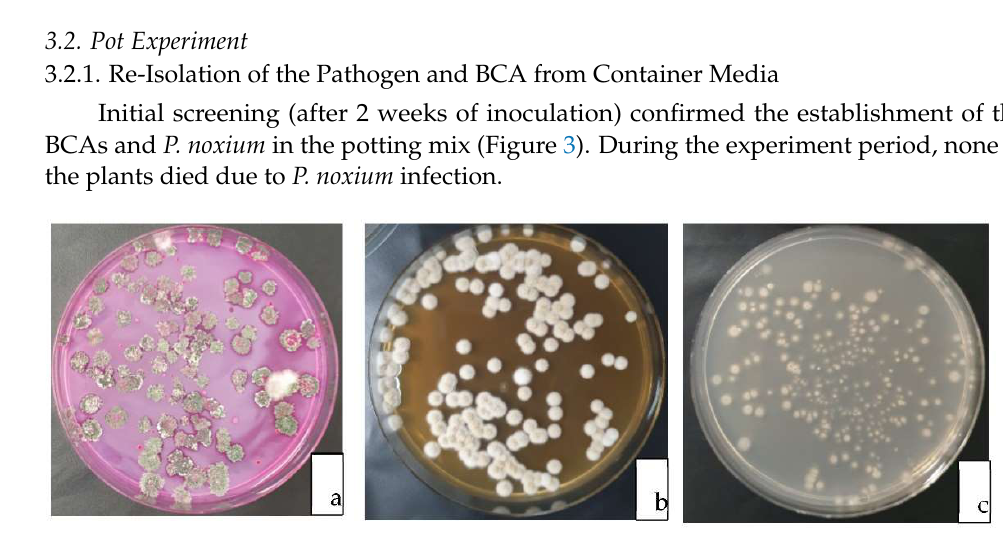
Figure 3. Re-isolation of ( a ) Trichoderma , ( b ) P. noxium and ( c ) streptomycetes on their